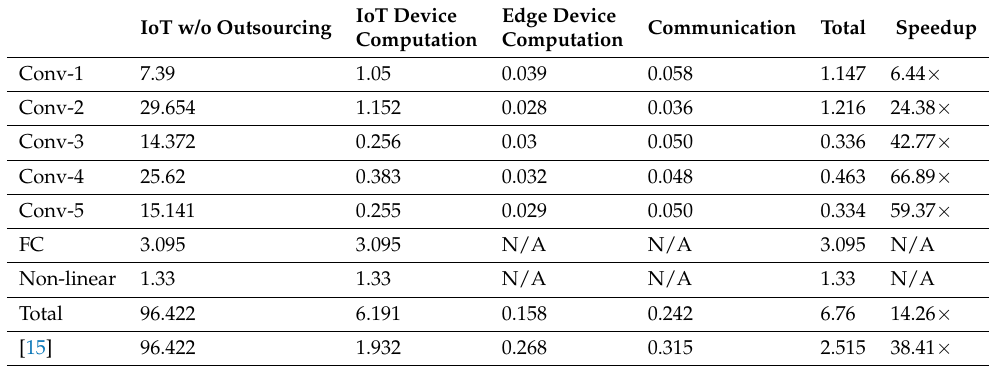
Table 5. Performance comparison with local execution. Time is measured in